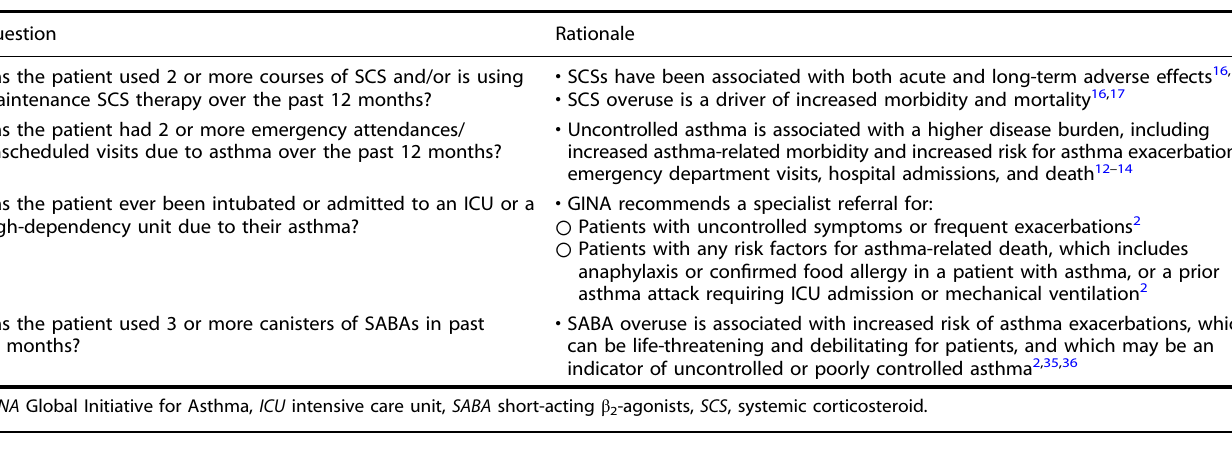
Table 3. ReferID